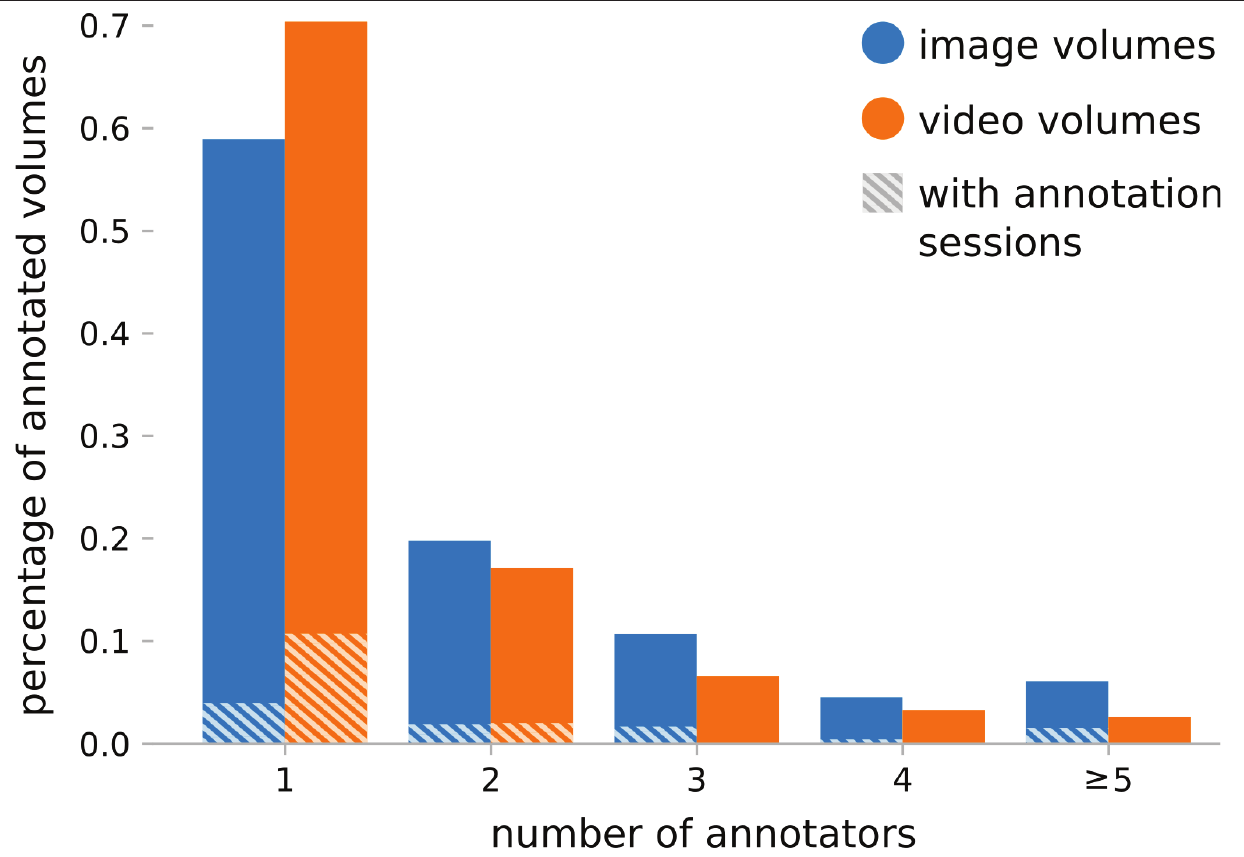
FIGURE 9 | Percentage of annotated image and video collections (volumes) on biigle.de, grouped by the number of distinct users who created annotations in the volume. The majority of volumes was annotated by only a single user. Only a low percentage of the volumes used annotations sessions that allow to determine the intraobserver and/or interobserver